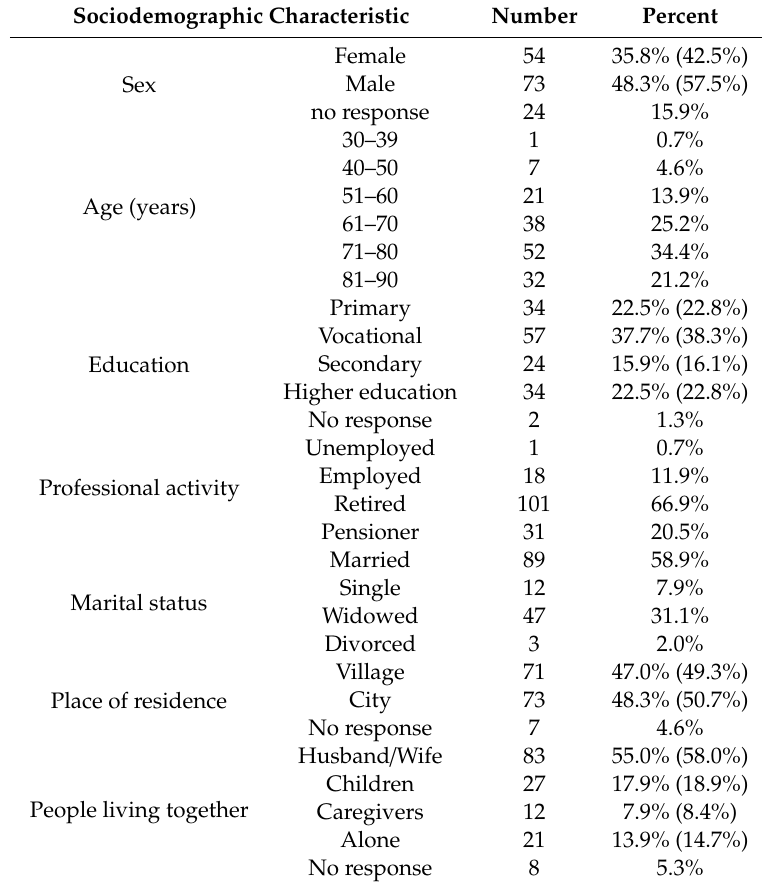
Table 1. Due to the fact that a significant percentage of the patients did not provide all the answers to the analyzed questionnaire, the table below also includes the percentage of responses without missing data (these percentages are given in brackets). Table 1. Sociodemographic characteristics of the studied group of